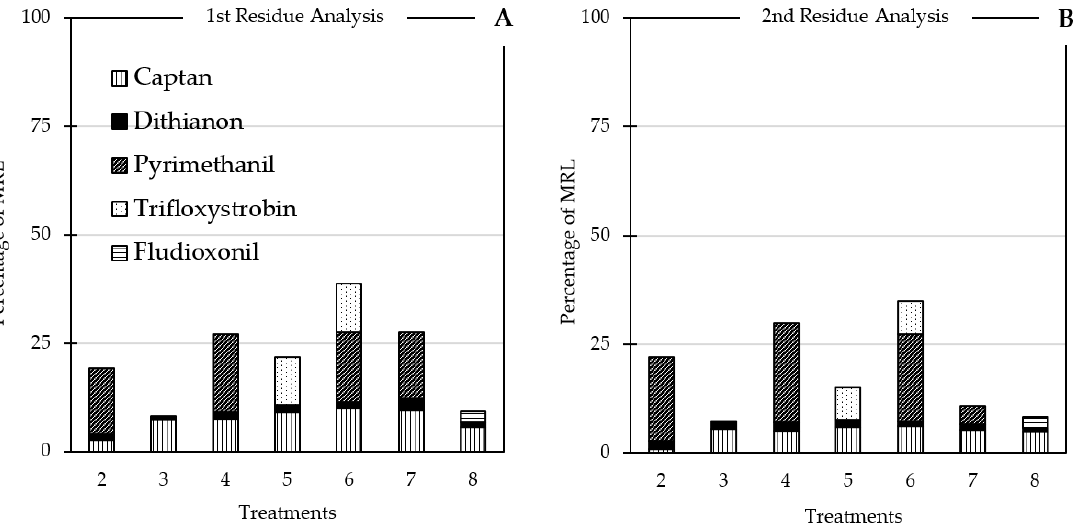
Figure 2. Results of MRL analysis of experimental treatments 2 to 8 after the application of pyrimethanil shortly after harvest ( A ) and after 5 months of RA storage ( B ). Cumulated percentages of maximum residues.